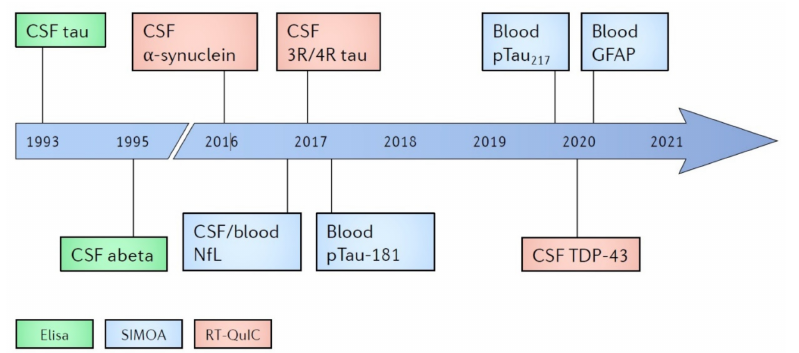
Figure 1. Timeline of the diagnostic biomarkers and methods. A β , beta-amyloid; CSF, cerebrospinal fluid; ELISA, enzyme-linked immunosorbent assay; GFAP, glial fibrillary acidic protein; NfL, neuro- filament light chain; pTau181, Tau phosphorylated at threonine 181; pTau217, Tau phosphorylated at threonine 217; RT-QuIC, real-time quaking-induced conversion; SIMOA, single-molecule enzyme- linked immunosorbent assay; TDP-43, TAR DNA-binding protein